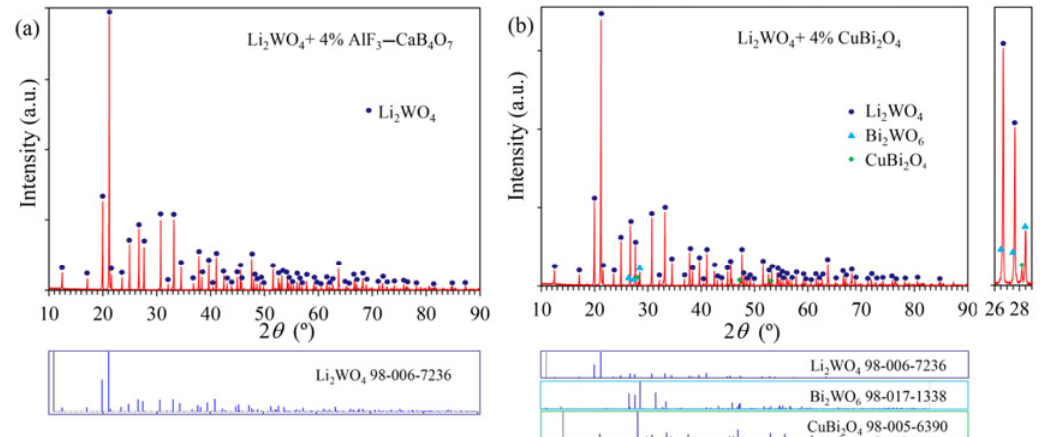
Fig. 1 Diffraction patterns of Li 2 WO 4 ceramics sintered at 610 ℃ : (a) doped with 4% AlF 3 –CaB 4 O 7 and (b) doped with 4% CuBi 2 O 4